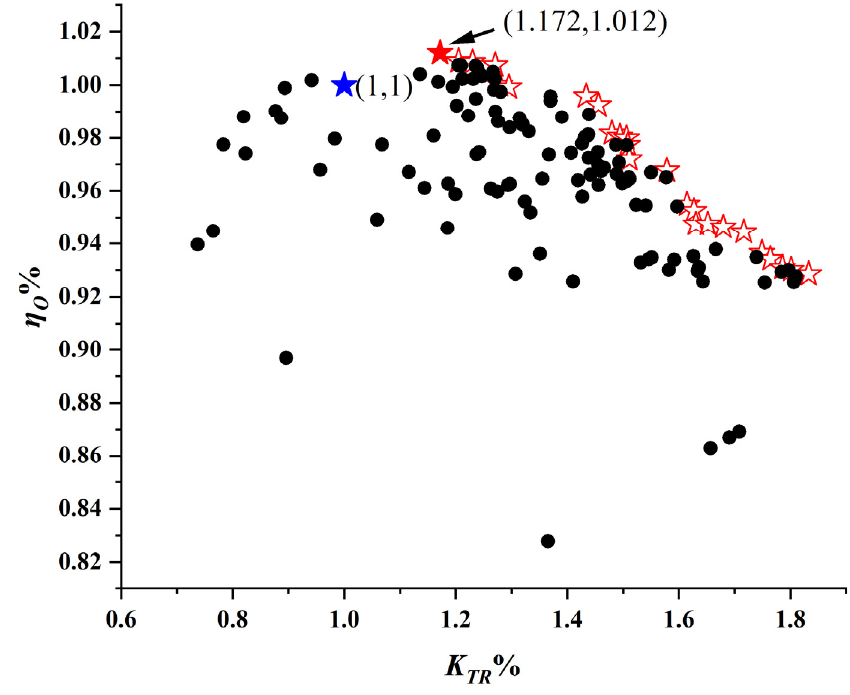
Figure 16. Schematic diagram of NSGA-II optimization solution set.